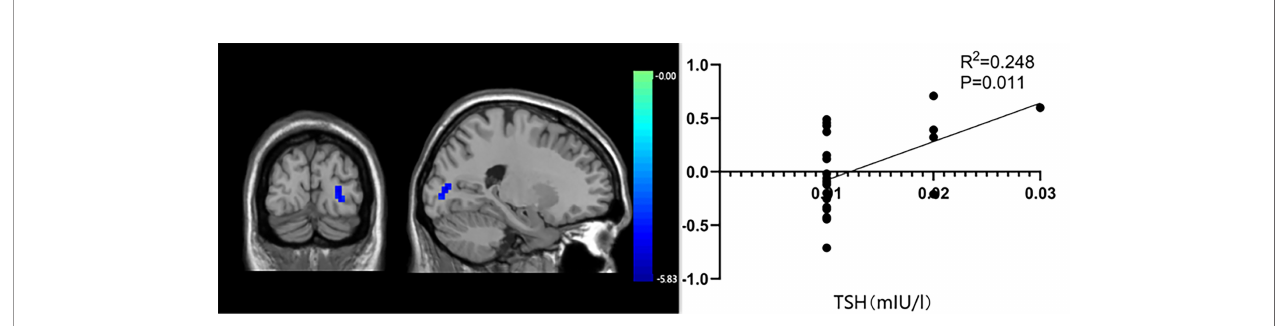
FIGURE 4 | The signi fi cant correlation between occipital lobe functional connectivity and thyroid stimulating